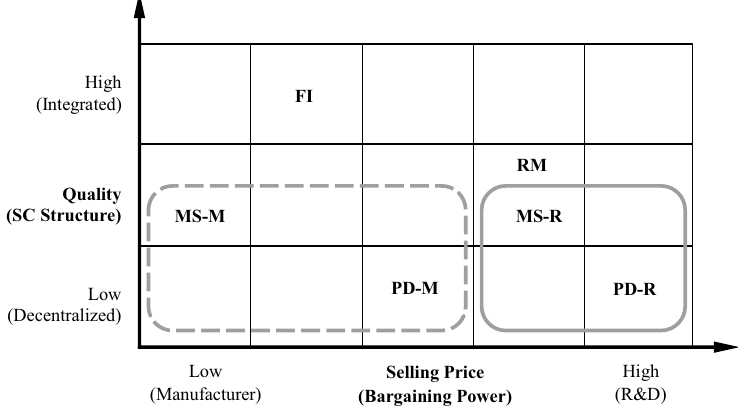
Fig. 2. Comparison of result of product quality and selling price in Proposition 3 (solid line: R&D controls; dotted line: manufacturer